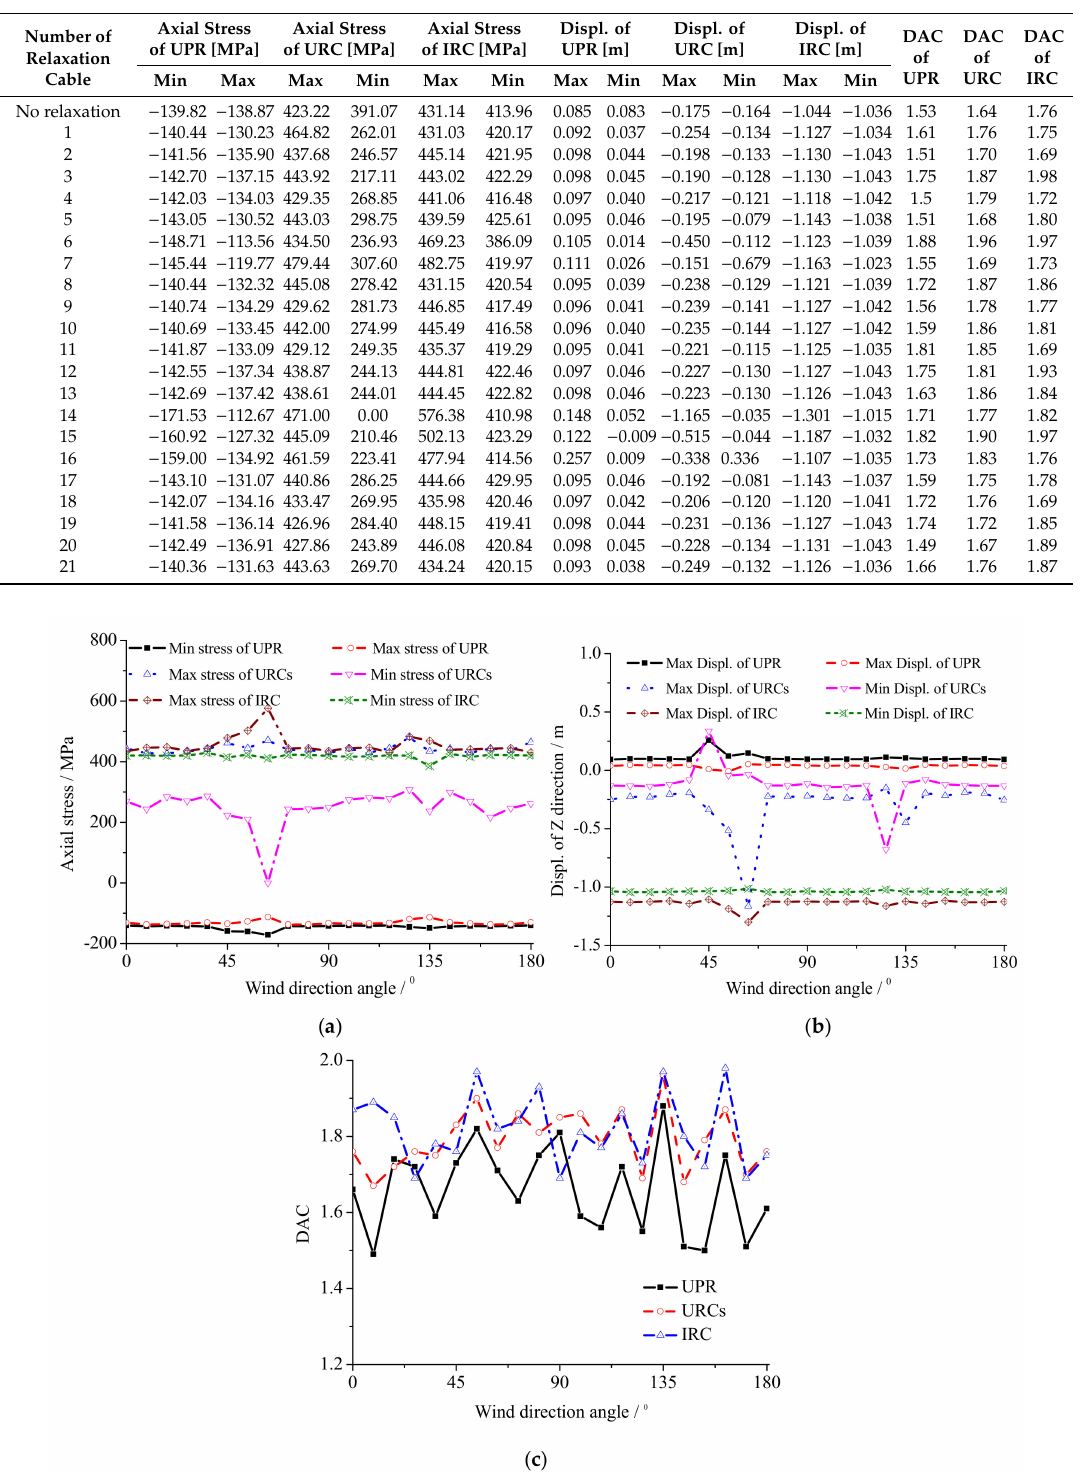
Table 4. Structural dynamic response under di ff erent cable relaxation degrees.